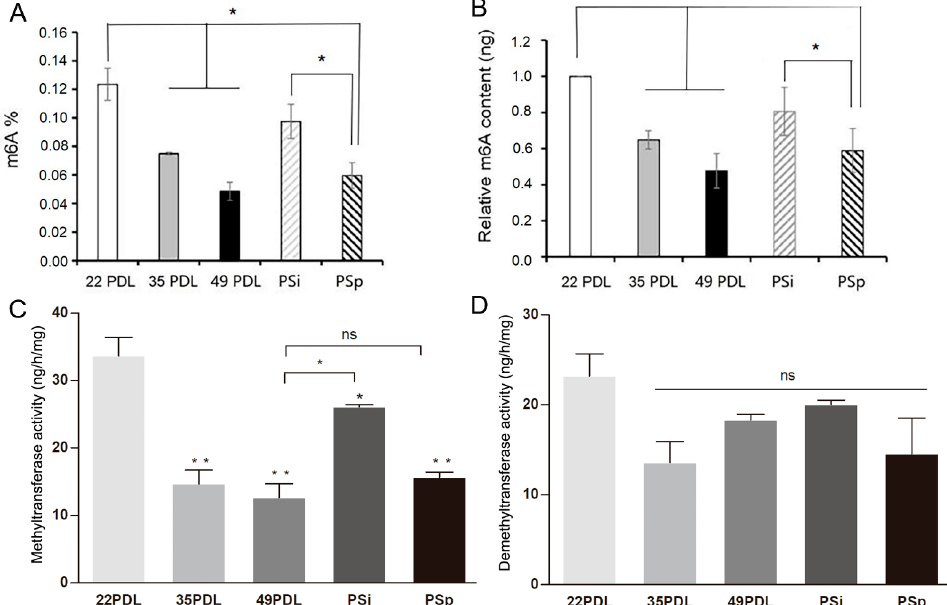
Figure 2. The overall m6A RNA methylation level and activities of enzymes associated with m6A modification. ( A ) The proportion of m6A-modified mRNA in 200 ng total RNA. ( B ) The relative m6A contents in each group. ( C ) The activity of methyltransferases, ng/h/mg. ( D ) The activity of demethyltransferases, ng/h/mg. The data are presented as the mean ± SEM ( n = 3). Compared with the 22PDL or 49PDL group, * p < 0.05, ** p < 0.01, or ns p > 0.05 .